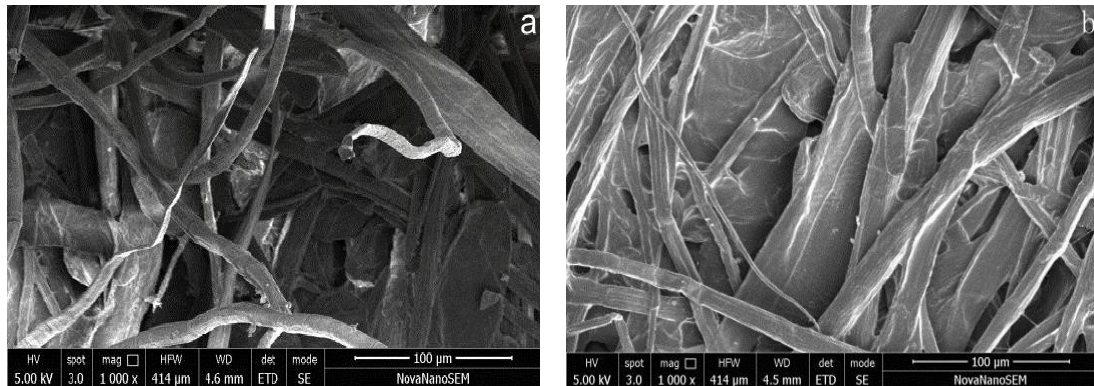
Figure 12. SEM images of Xuan paper treated before ( a ) and after ( b ) with polyurethane liquid.